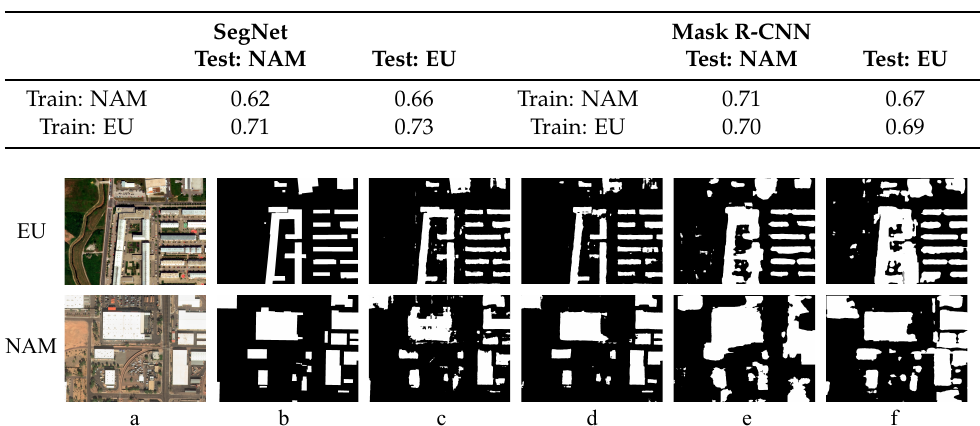
Table 6. Generalization across continents (RQ4): DICE scores of SegNet and Mask R-CNN trained on European data (EU) and North American data (NAM) and tested for test sets of both continents.